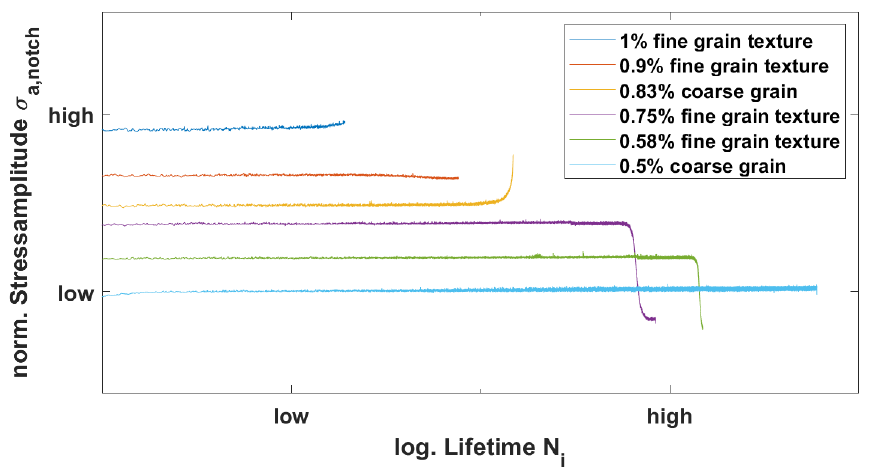
Figure 9. Development of stress amplitude over lifetime during strain-controlled LCF testing at 850 °C for coarse-grain and fine-grain textured material.